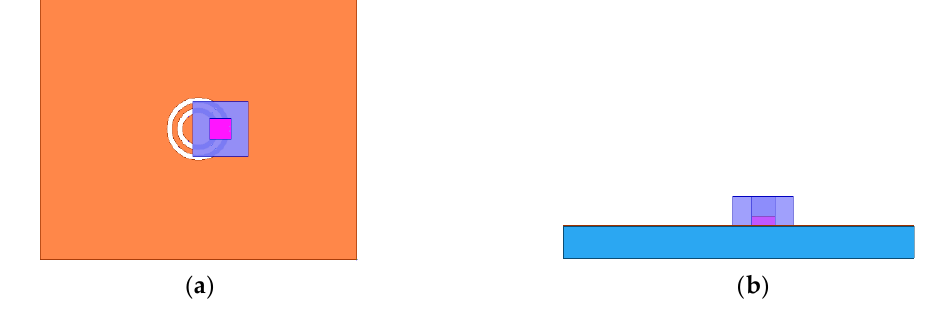
Figure 11. Simulation model of the proposed sensor using a High-Frequency Simulator Structure (HFSS) with the material under test filling the channel drawn by acrylic paint ( a ) Top view; ( b ) Side view.